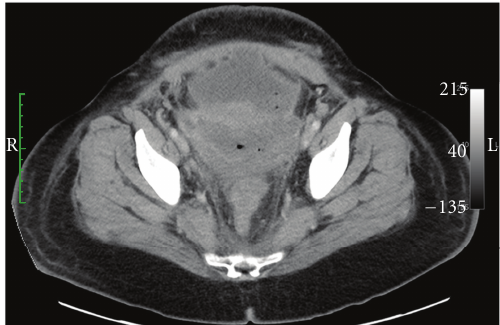
Figure 4: This axial CT-obtained cranial to the urinary bladder reveals disorganized lower uterine wall anatomy, a peritoneal fluid collection, and scattered gas bubbles in the uterus and peritoneum.